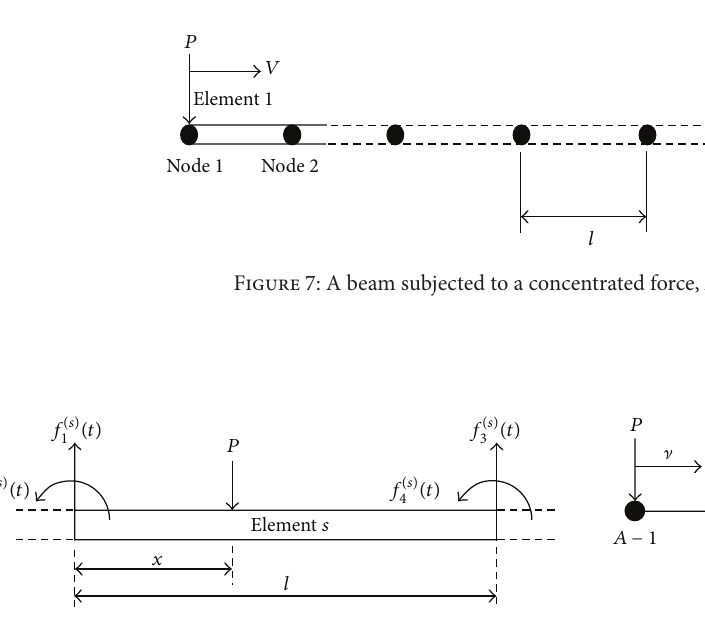
Figure 8: The equivalent forces of element 𝑠 subjected to a concentrated force 𝑃 .